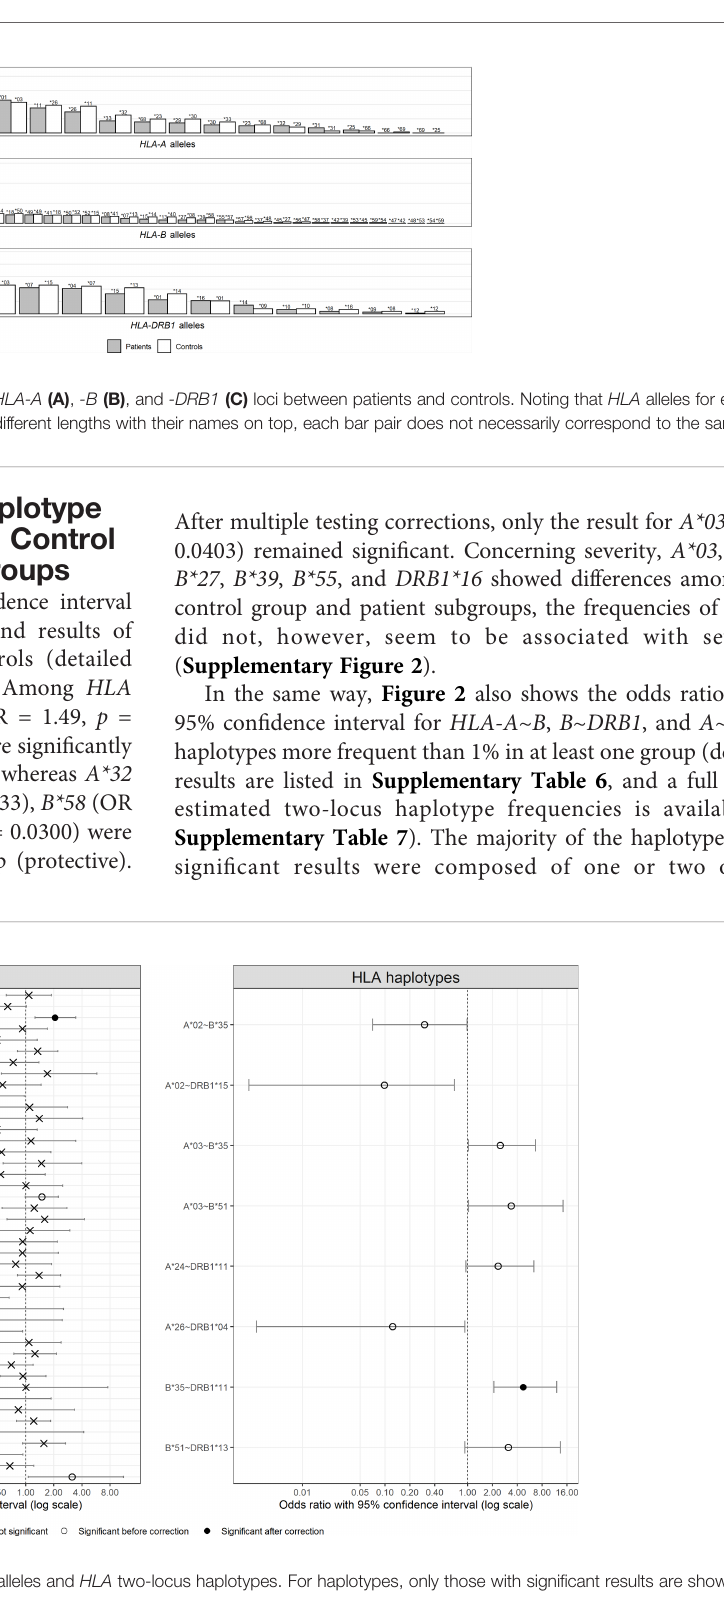
FIGURE 2 | Odds ratio with 95% con fi dent intervals for HLA alleles and HLA two-locus haplotypes. For haplotypes, only those with signi fi cant results are shown. Signi fi cance is represented by different symbols: crosses for non-signi fi cant results; circles for signi fi cant results before correction and dots for signi fi cant results after correction.